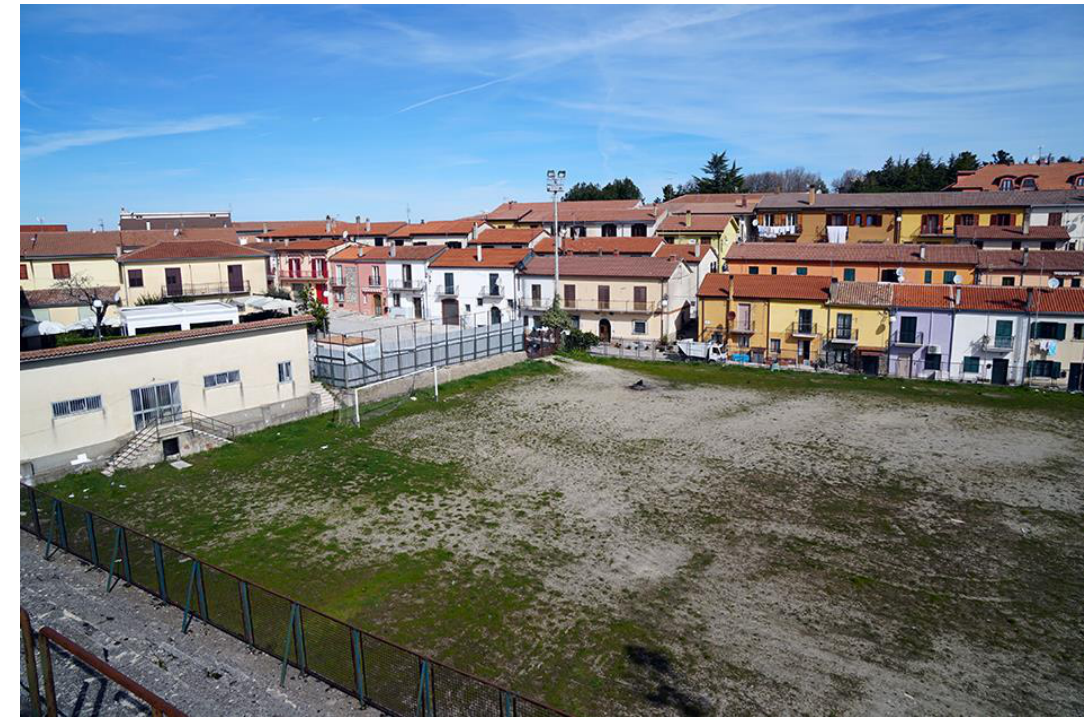
Figure 39. Sant’Angelo dei Lombardi: overview of new buildings and the football field (photos by [35,36]).